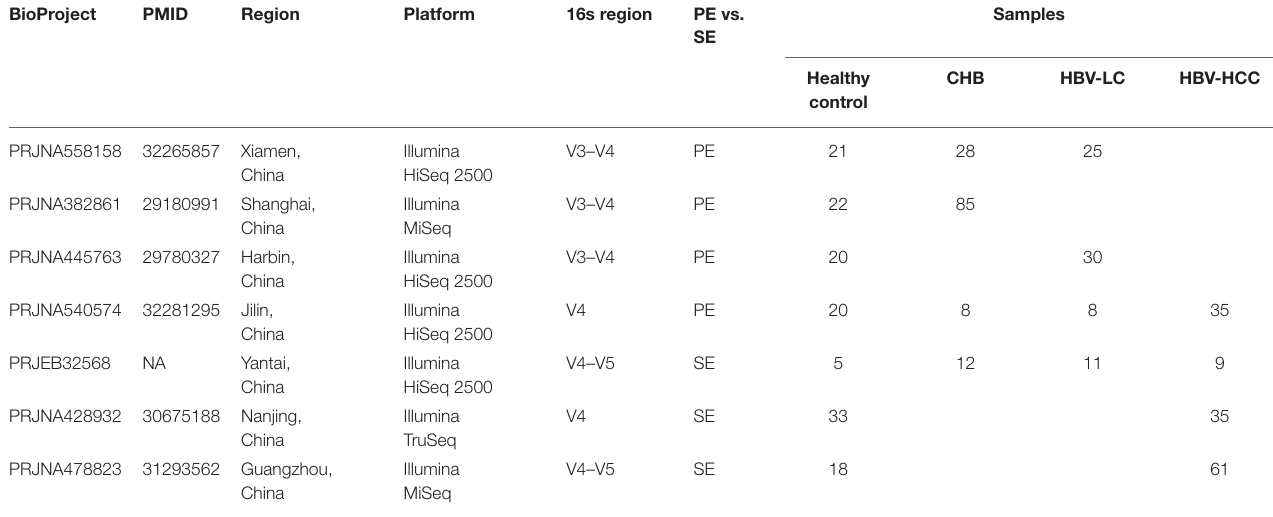
TABLE 1 | Summary of the public datasets included in the meta-analysis.